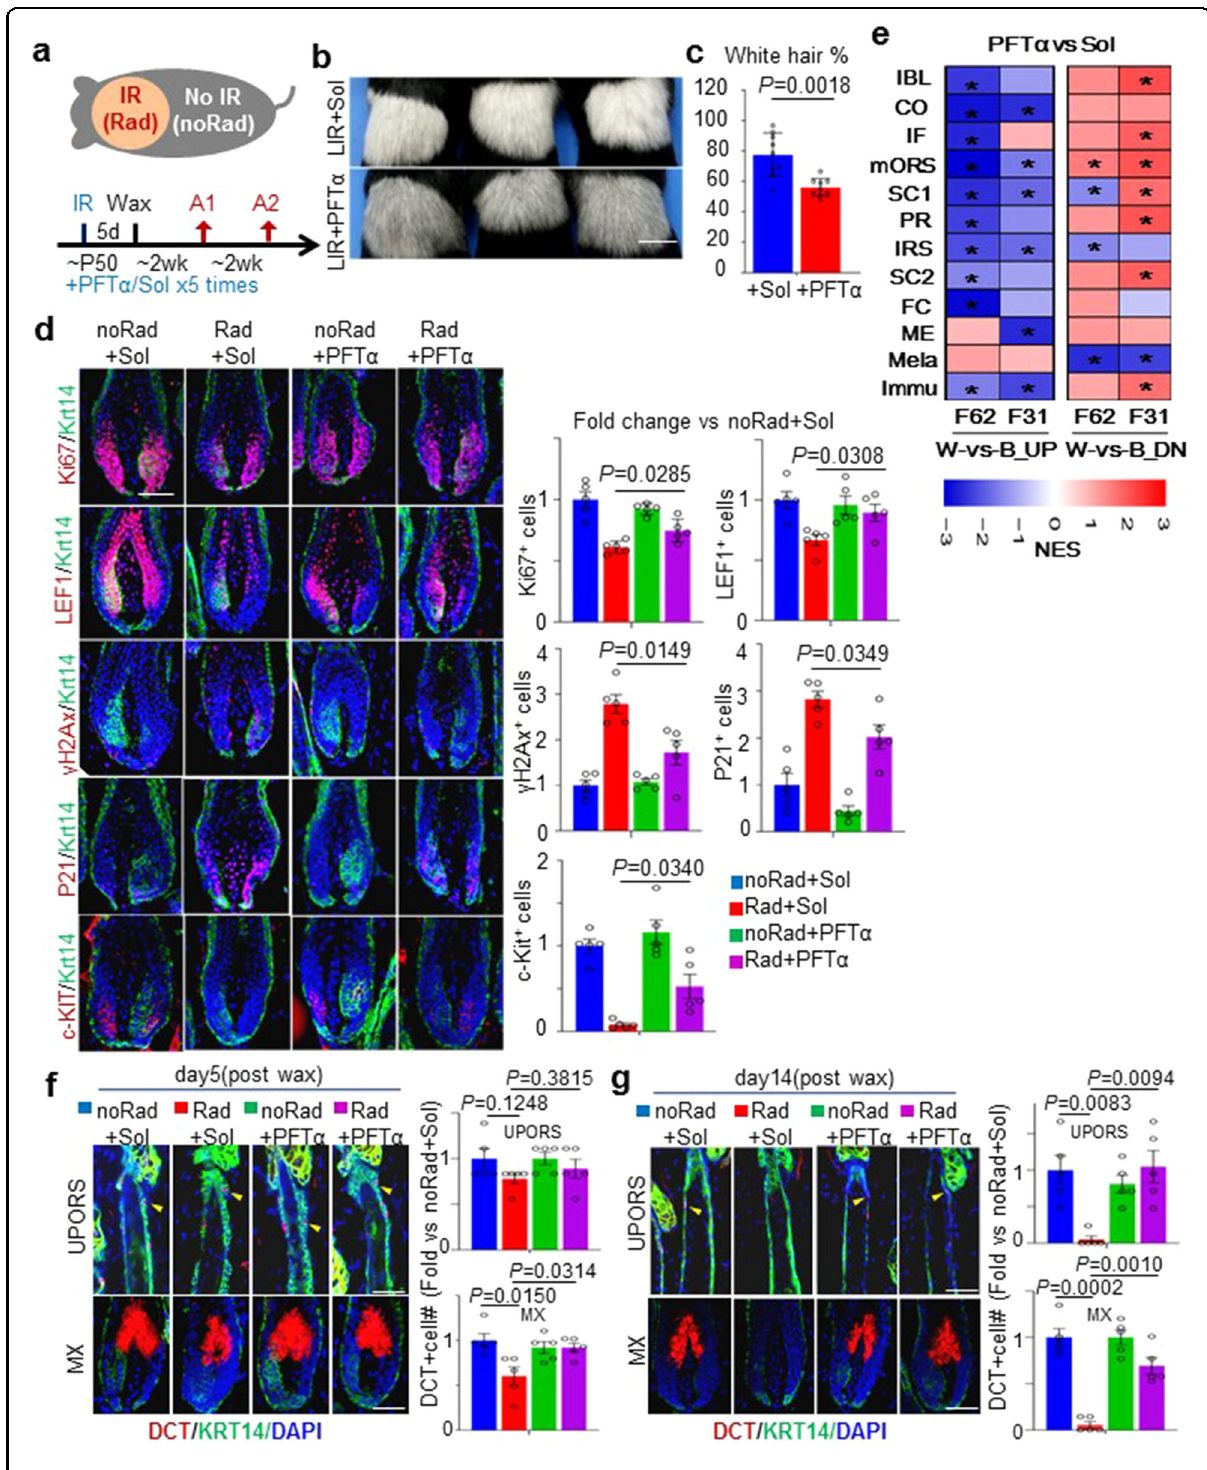
Fig. 6 (See legend on next